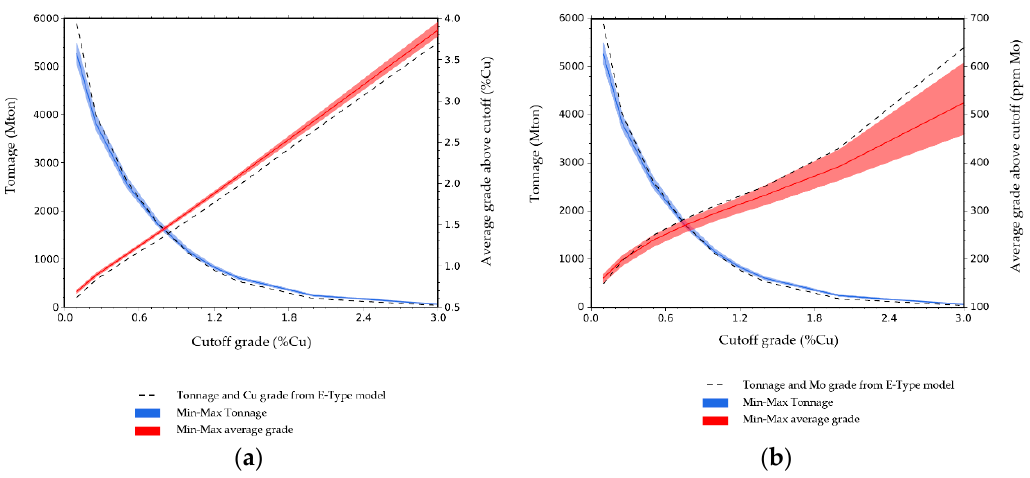
Figure 9. Grade-tonnage curves, with cutoff grade (% Cu). ( a ) Average grade above cutoff (% Cu), and ( b ) Average grade above cutoff (ppm Mo). Results from simulations and E-Type models.